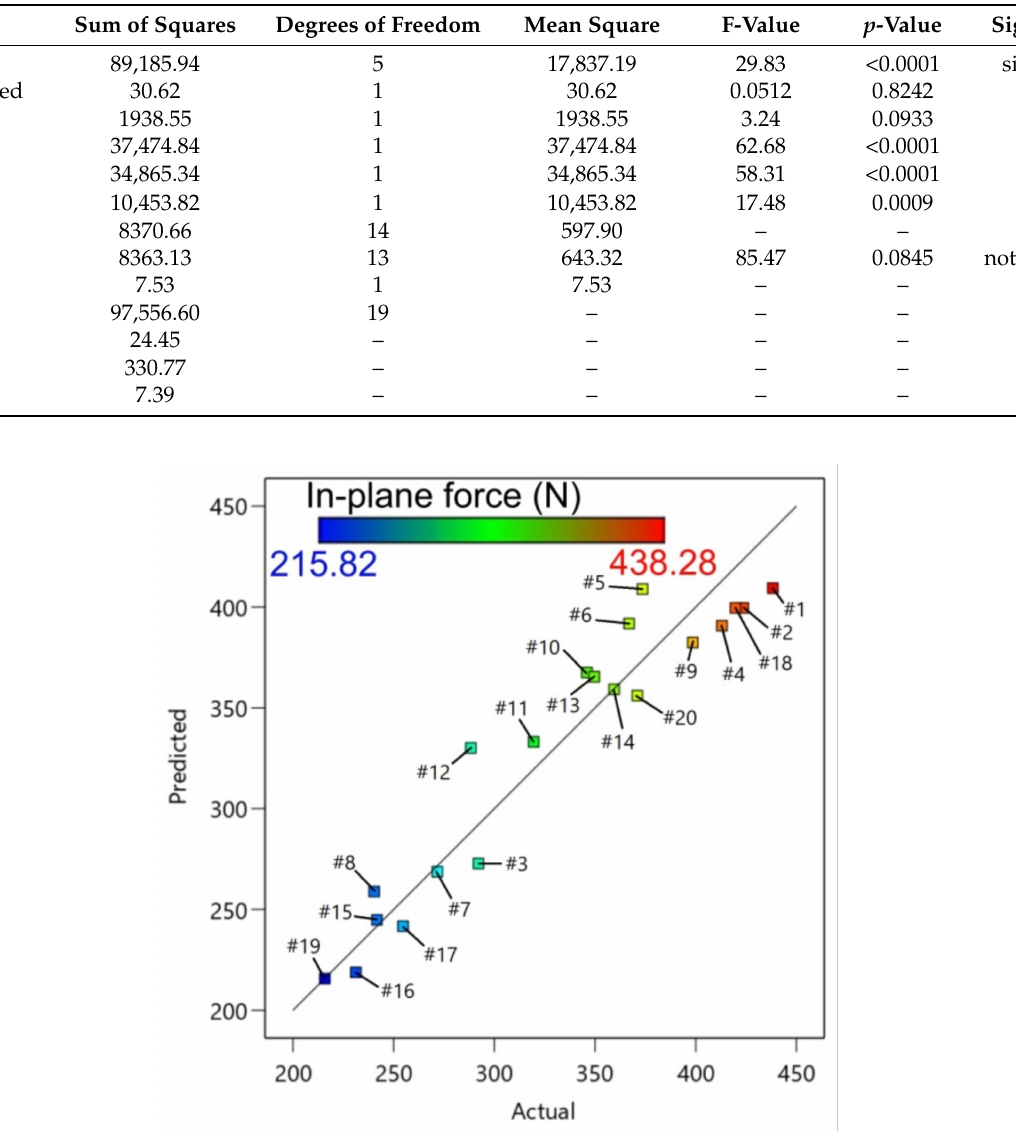
Table 6. ANOVA results of the in-plane force in SPIF.